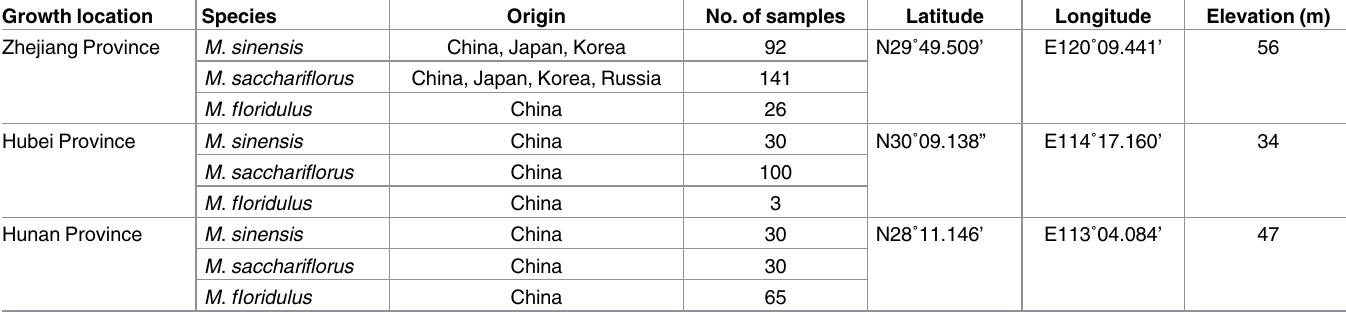
Table 1. Information of Miscanthus species, amount, locations in the sampling regions. Growth location